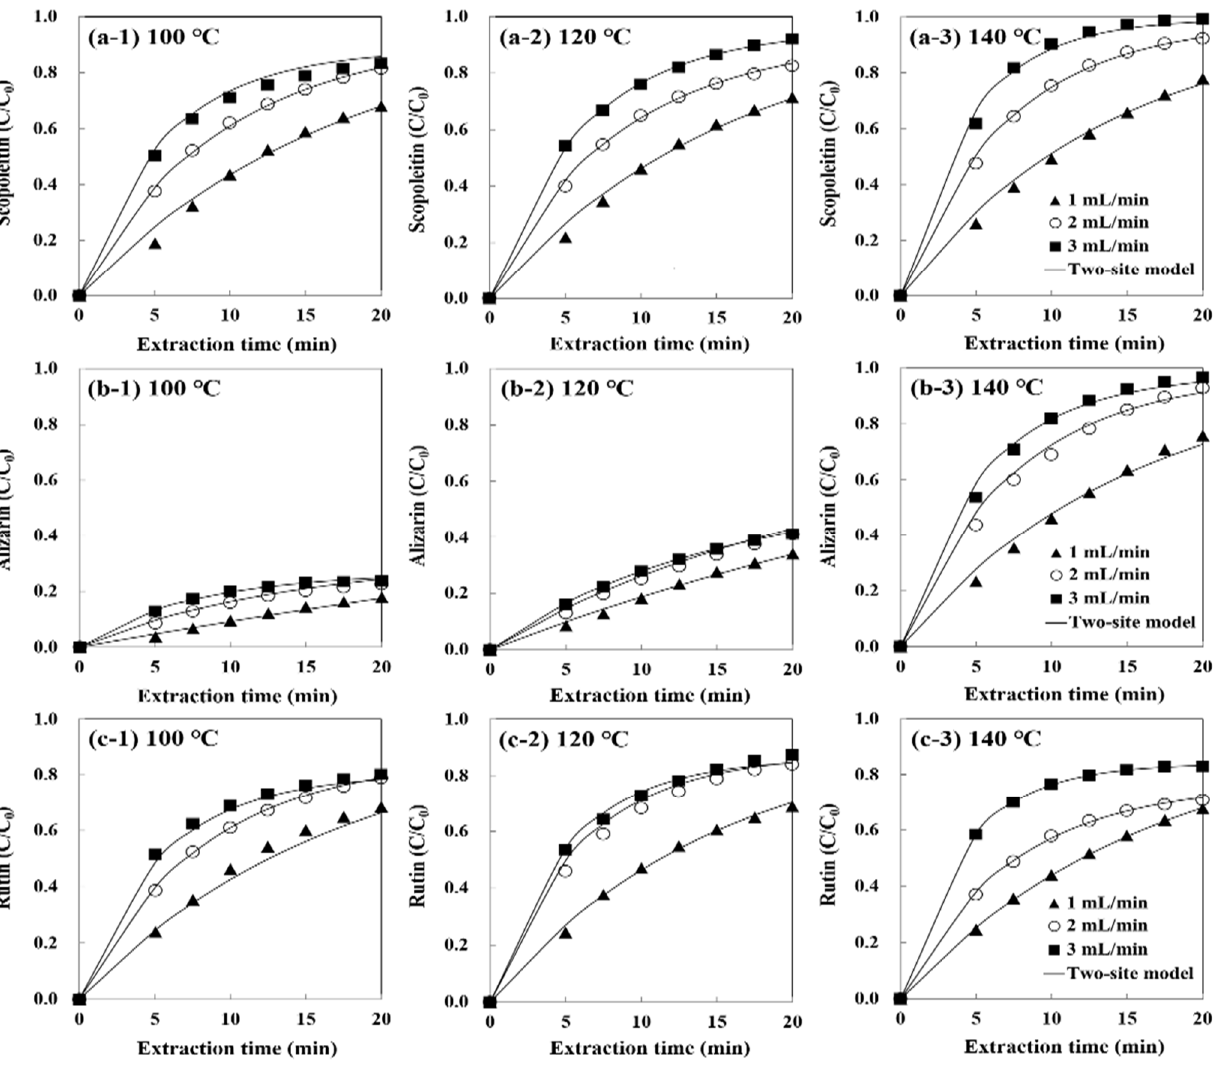
Figure 5. The two-site kinetic desorption model fit for the experimental values on subcritical water extraction of ( a ) scopoletin, ( b ) alizarin, and ( c ) rutin from noni fruits. The points represent the experimental values, and the solid lines are predicted in this model equation.